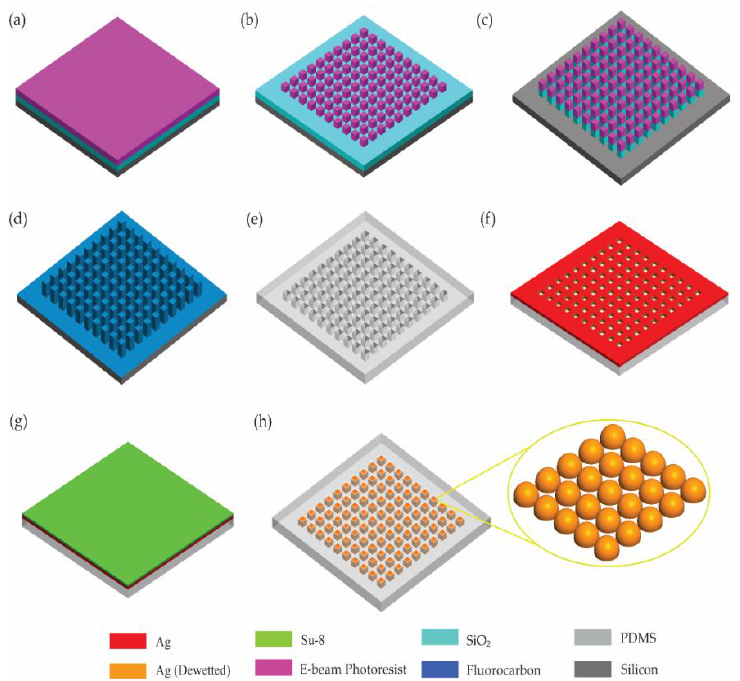
Figure 5. Illustration of the fabrication process of Ag nanoislands in nanowells embedded in a PDMS membrane. ( a ) SiO 2 deposition on a Si wafer, followed by spin coating of an e-beam photoresist. ( b ) E-beam lithography. ( c ) RIE to generate a nanowell template. ( d ) Fluorocarbon coating to render the template surface hydrophobic. ( e ) Fabrication of a PDMS mold from the template. ( f ) Ag deposition into the PDMS nanowells. ( g ) Dewetting with SU-8 spin coated on a glass slide. ( h ) Removal of the SU-8.